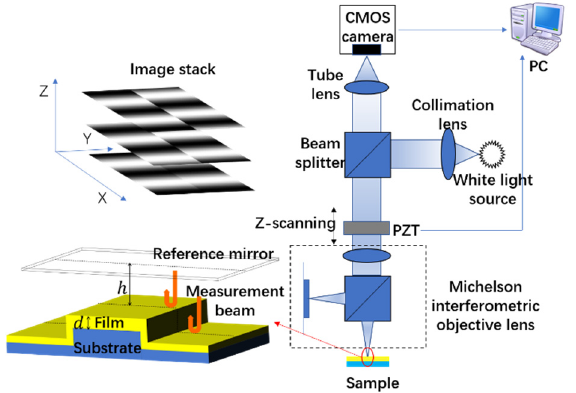
Figure 1. White-light interference microscopy system based on a Michelson interferometer.